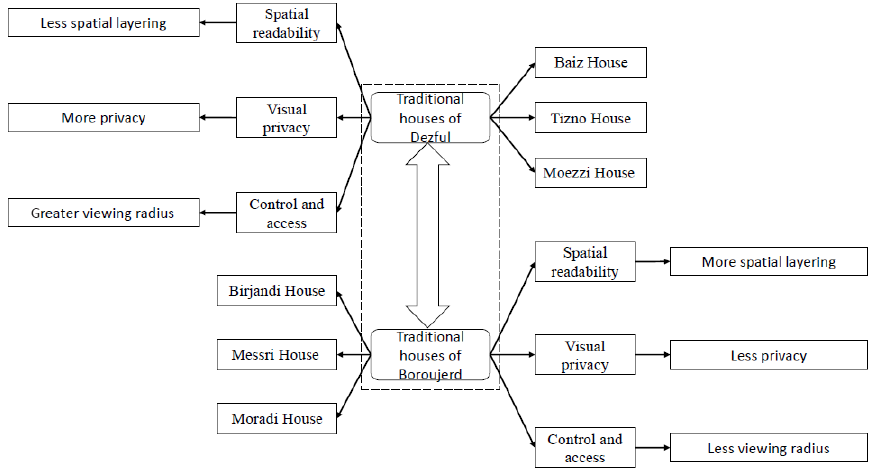
Figure 7. Recognition of the spatial configuration of traditional houses in Dezful and Boroujerd (source: compiled by the authors) Table 6. Structural differences in the spatial configuration of traditional housing in Dezful and Boroujerd (source: compiled by the